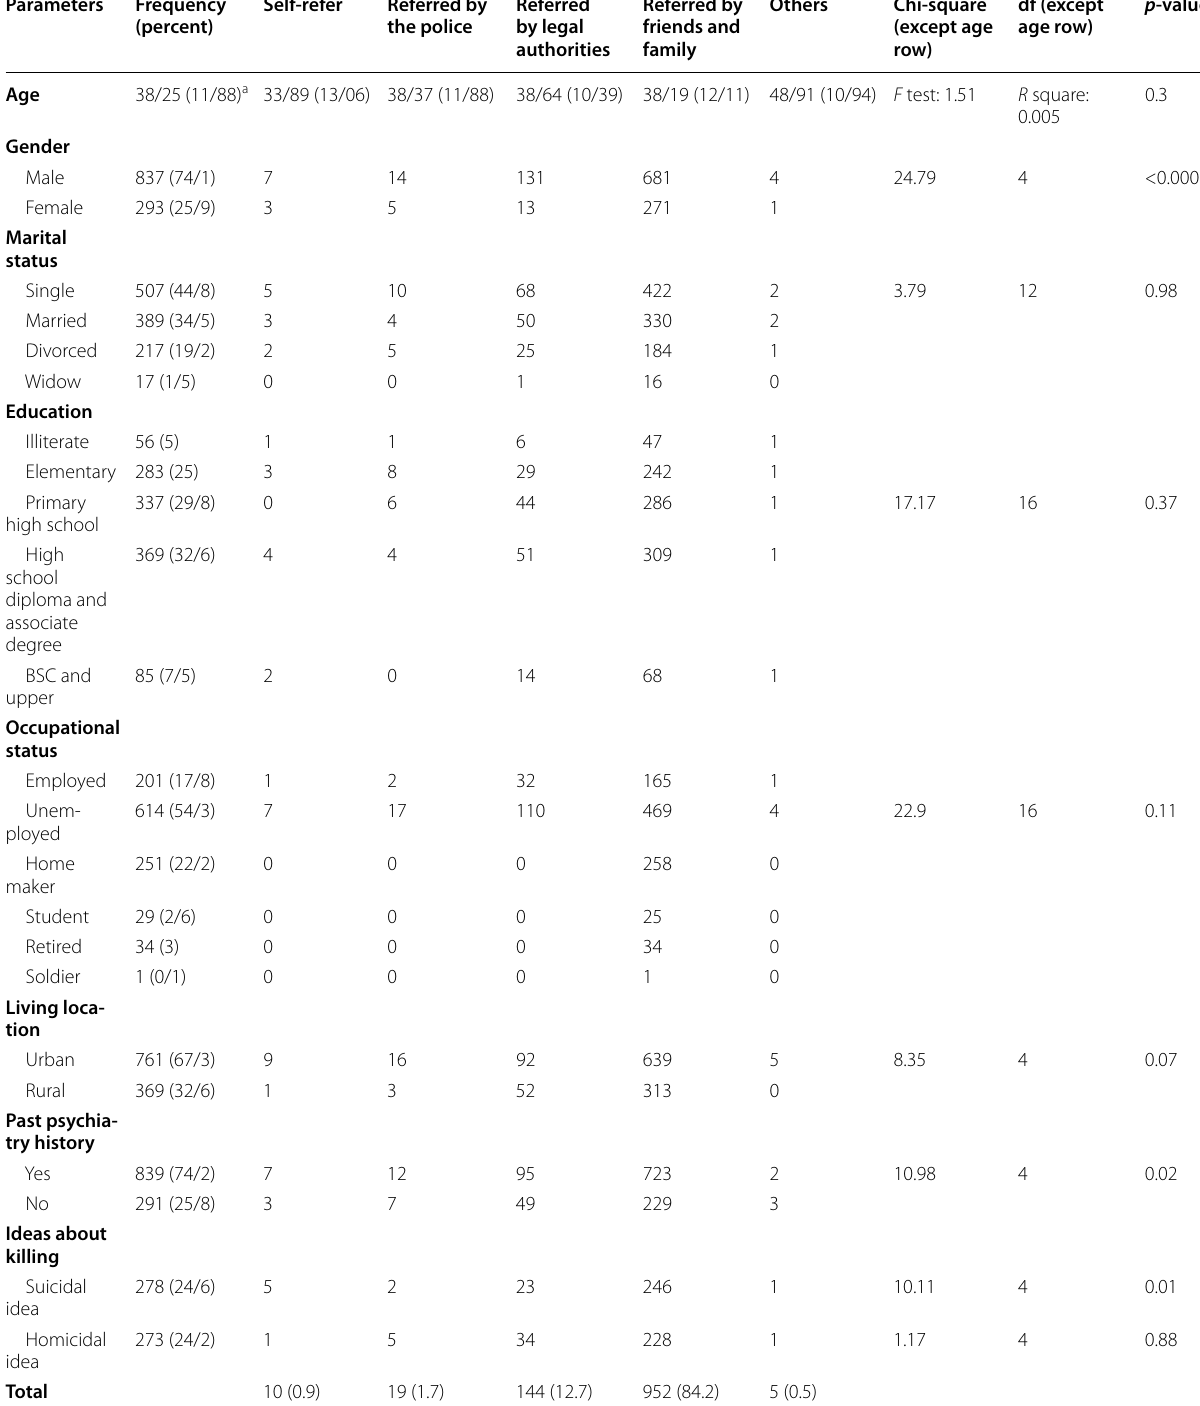
Table 1 Demographic and clinical characteristics of patients referred by different sources to the psychiatric wards of Zare Hospital, Sari,